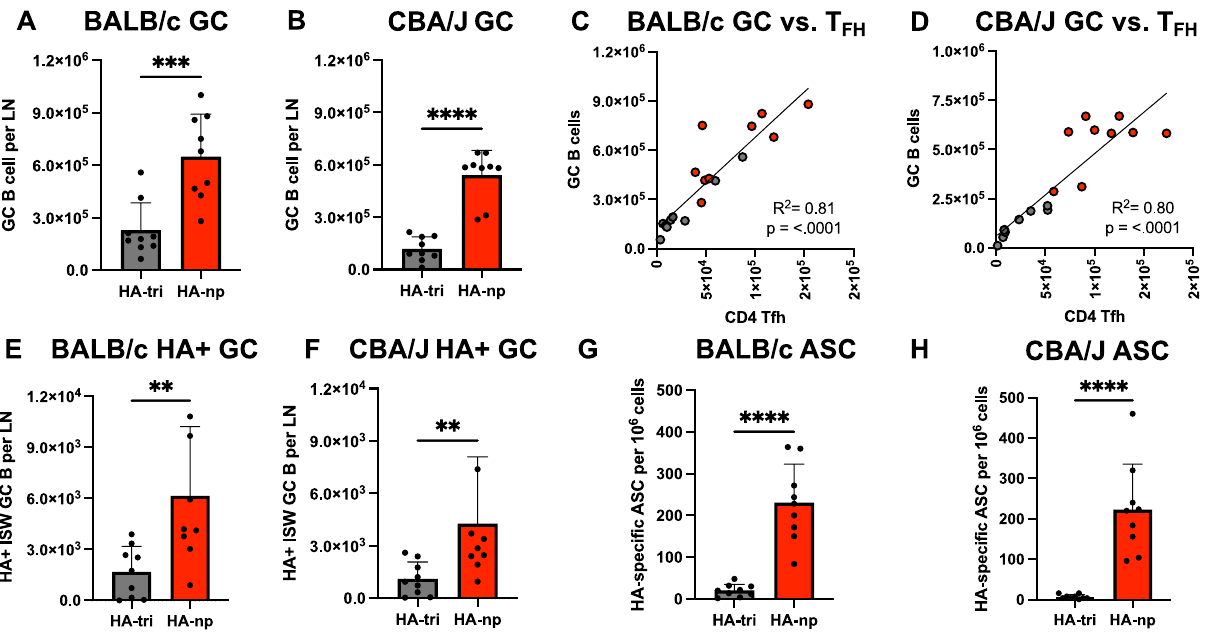
Fig. 4 HA-nanoparticle immunization elicits enhanced antigen-speci fi c B cell responses that correlate strongly with abundance of T FH . Total abundance of FAS + GL7 + germinal center B cells per lymph node was assessed in A BALB/c and B CBA/J mice immunized with equimolar quantities of HA in the form of soluble HA trimers or HA-nanoparticles from the same individual mice shown in Fig. 3. The relationship between germinal center B cell abundance and CD4 T FH abundance was assessed by linear regression analysis for C BALB/c and D CBA/J mice immunized with HA trimers or HA-nanoparticles. When cohorts vaccinated with HA-trimers and HA-Fe-nanoparticles are separately analyzed by linear regression analyses, the same trend is observed. Antigen-speci fi c GC B cell responses were assessed by staining with fl uorophore conjugated HA probes, where the B cell population of interest was de fi ned as FAS + GL7 + IgM- IgD- HA + for E BALB/c and F CBA/J mice. HA-speci fi c ASCs were assessed by B cell ELISpot. The frequency of HA-speci fi c IgG isotype B cells was assessed for G BALB/c and H CBA/J mice. Data are shown as the mean of three individual mice per group from three independent experiments, for a total of 9 individual mice per group. In ( A , B , E , F , G , H ), signi fi cant differences between HA-trimer and HA-nanoparticle immunized mice were determined by unpaired, two-tailed Mann-Whitney